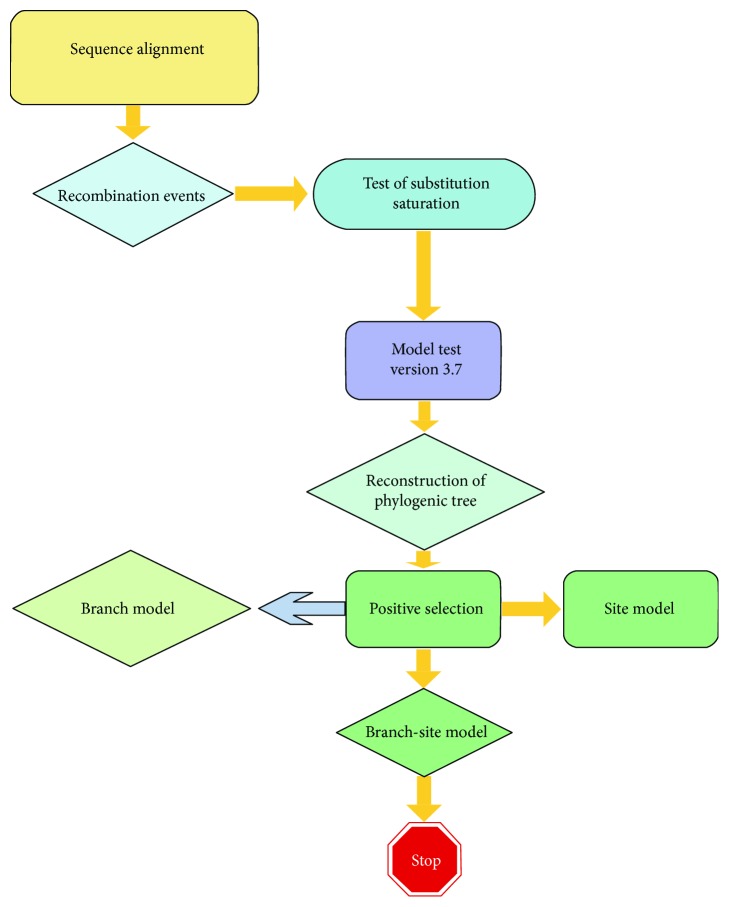
Technical routes of positive selection analysis in the site model, branch model, and branch-site model for SQS sequences in plants.